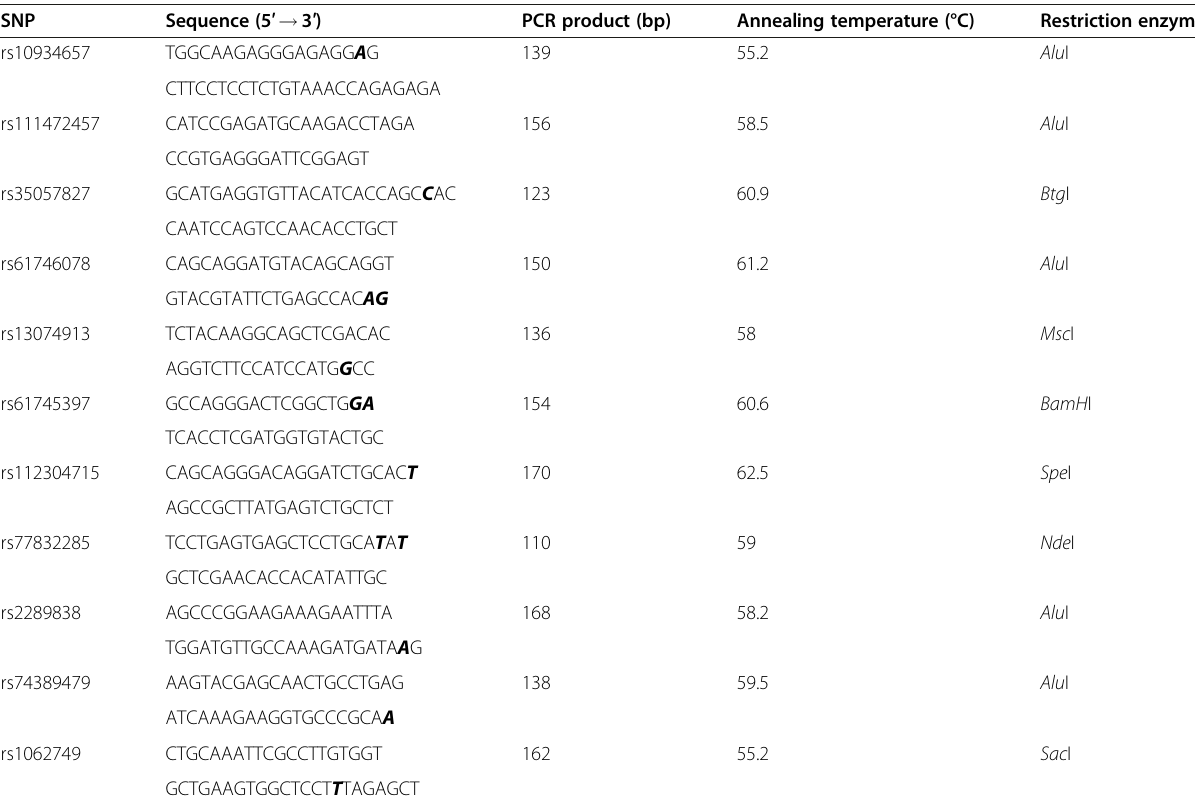
Table 1 Primer design for fragment length analysis SNP Sequence (5 ′ ! 3 ′